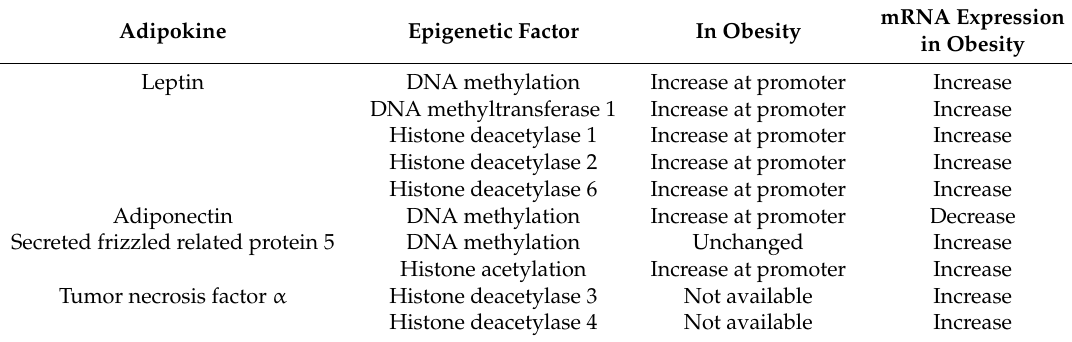
Table 1. Adipokines’ expression in obesity and association with epigenetic